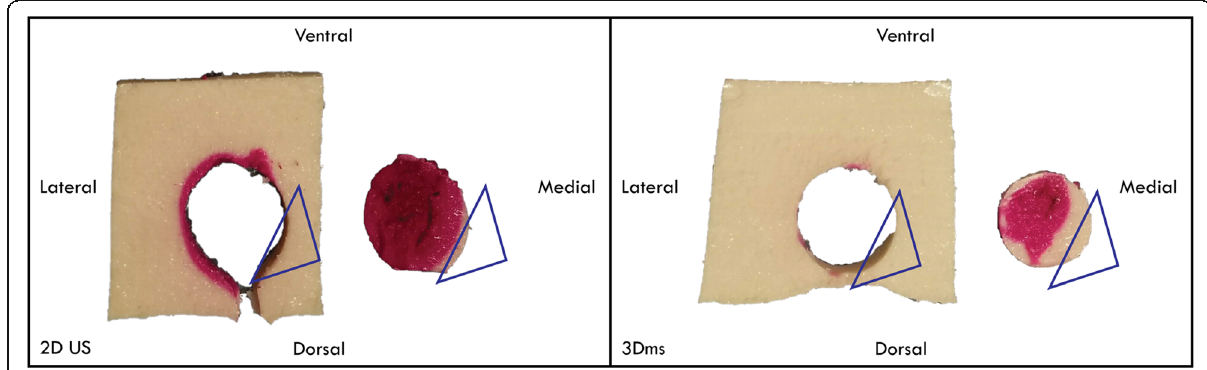
Fig. 4 Ablation results using conventional two-dimensional (2D) and three-dimensional mechanically swept (3Dms) transducer guidance. The blue triangle indicates the danger triangle, free from ablation in the nodule and outside the nodule. The magenta colour in the body indicates an overablation outside the